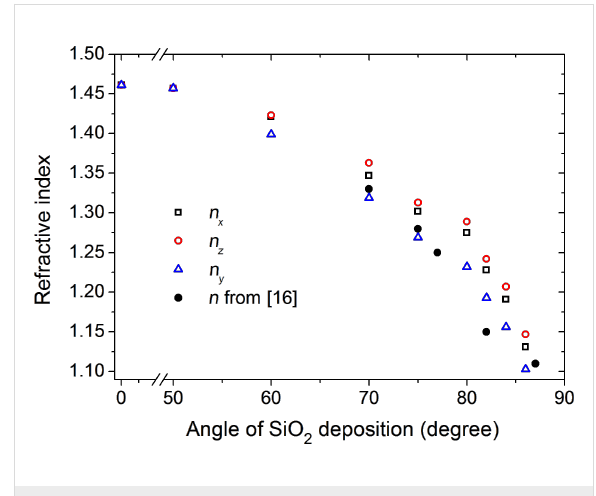
Figure 3: The anisotropic refractive index (nonfilled symbols) of porous SiO 2 at λ = 532 nm vs angle of deposition. Also shown is the isotropic refractive index from [16] (filled